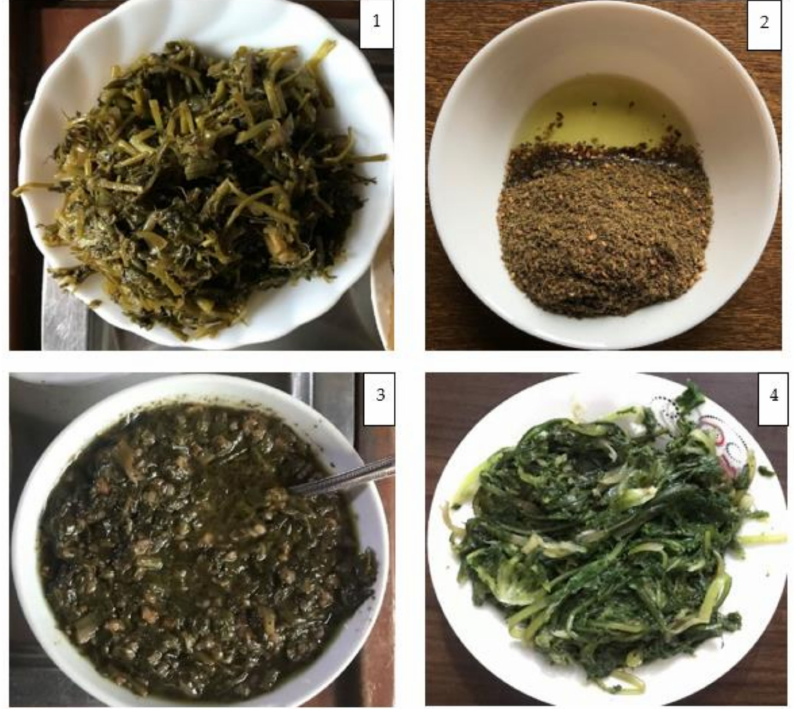
Figure 2. The most popular wild plant-based dishes. ( 1 ): Sleeq dish; ( 2 ): Zaatar dish with olive oil; ( 3 ): Louf soup; ( 4 ): Shabshuleh